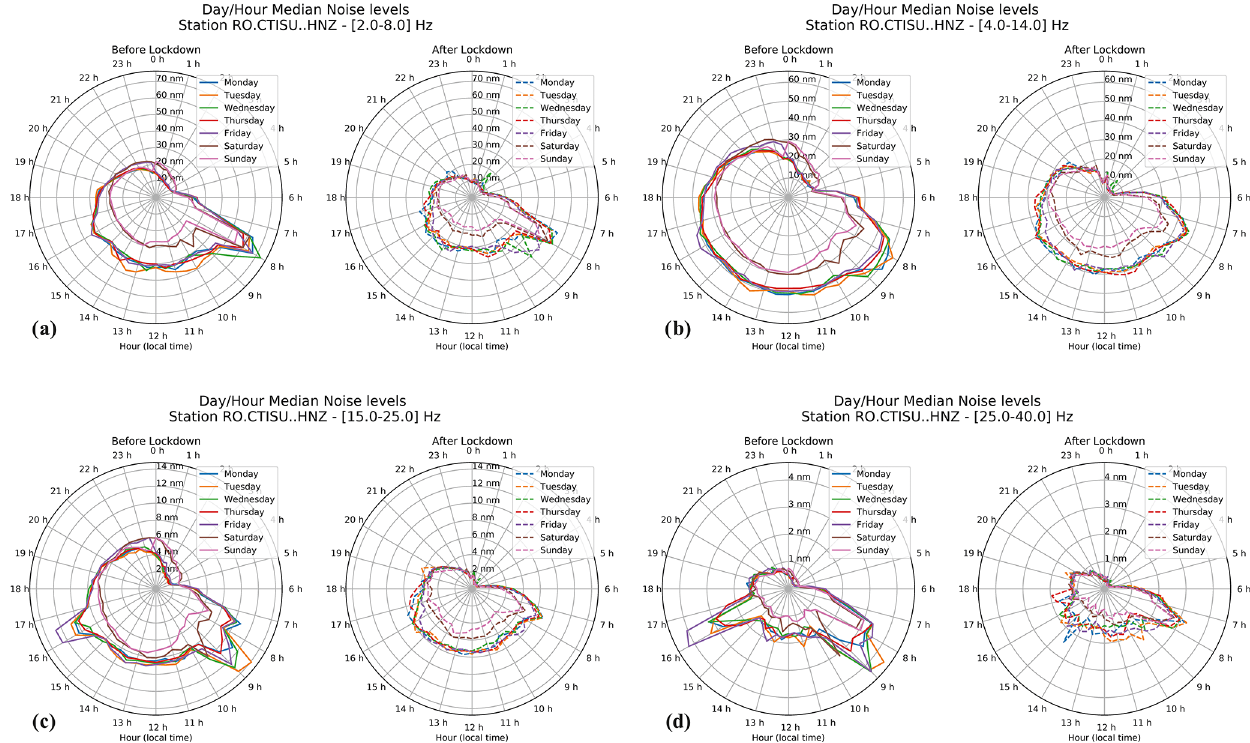
Figure 6. Lockdown effects shown on 24h clock plots at station CTISU in Constanta city for the frequency bands 2–8Hz (a) , 4–14Hz (b) , 15–25Hz (c) , and 25–40Hz ( d ) (see Fig. 1 for the station locations).